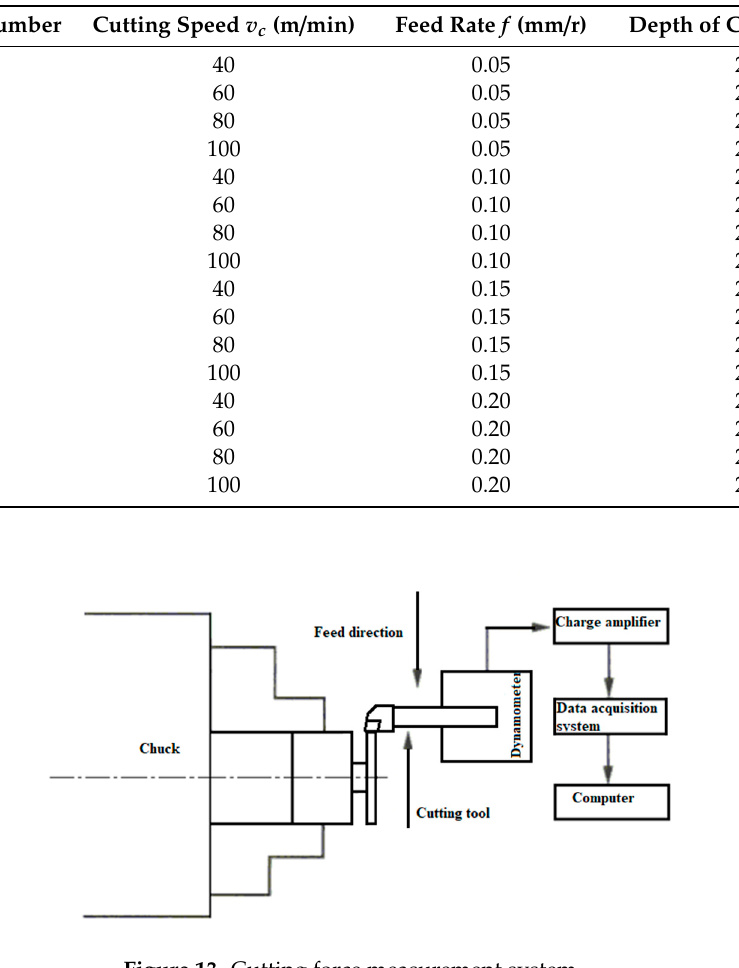
Figure 13. cutting force measurement system.